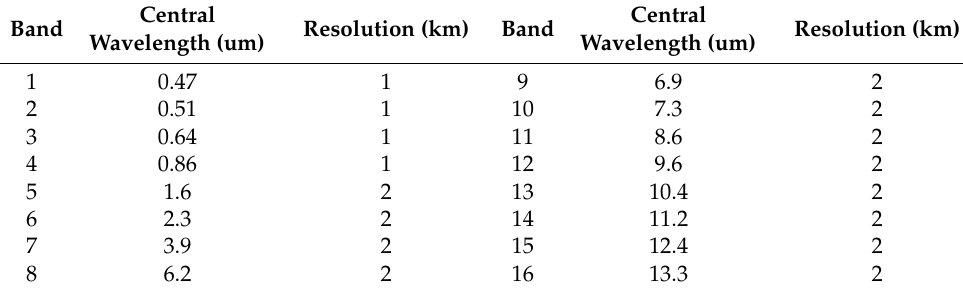
Table 3. Band parameters of ALI carried on